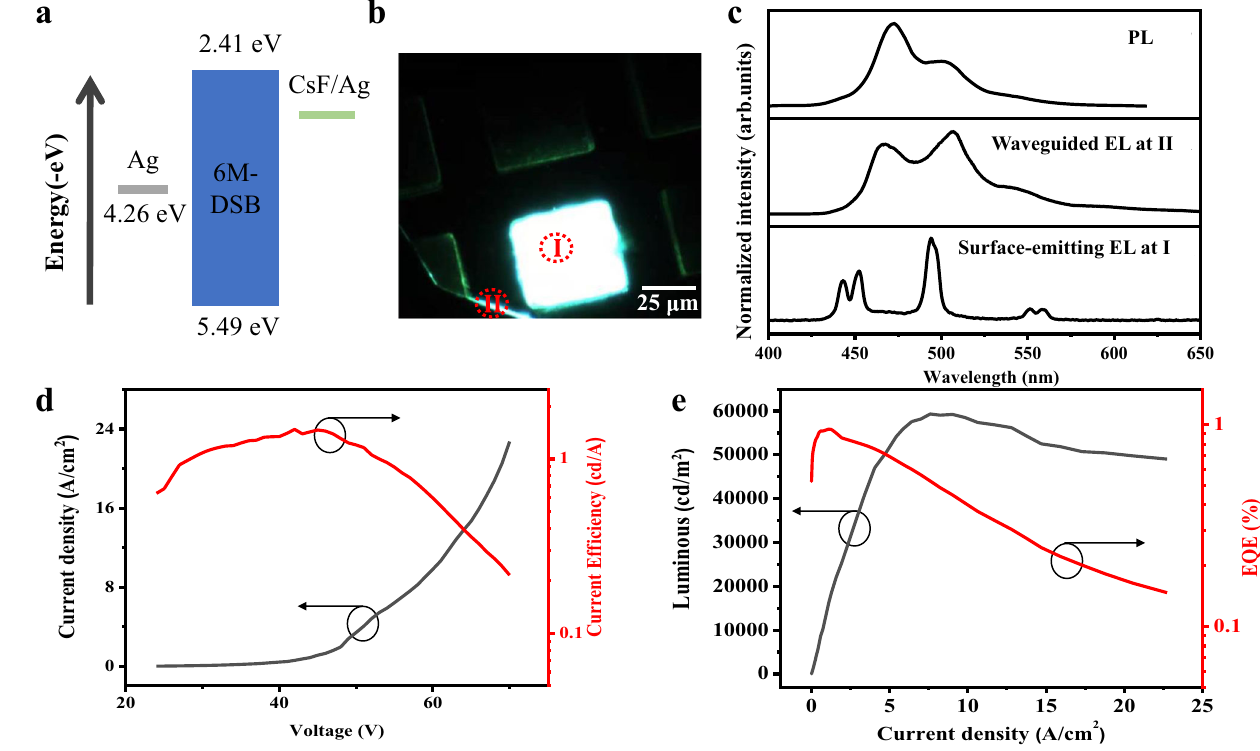
under EL as shown in b . d Dependence of the current density (black line) and the current ef fi ciency (red line) on the voltage. e Dependence of the luminescence (black line) and the EQE (red line) on the current